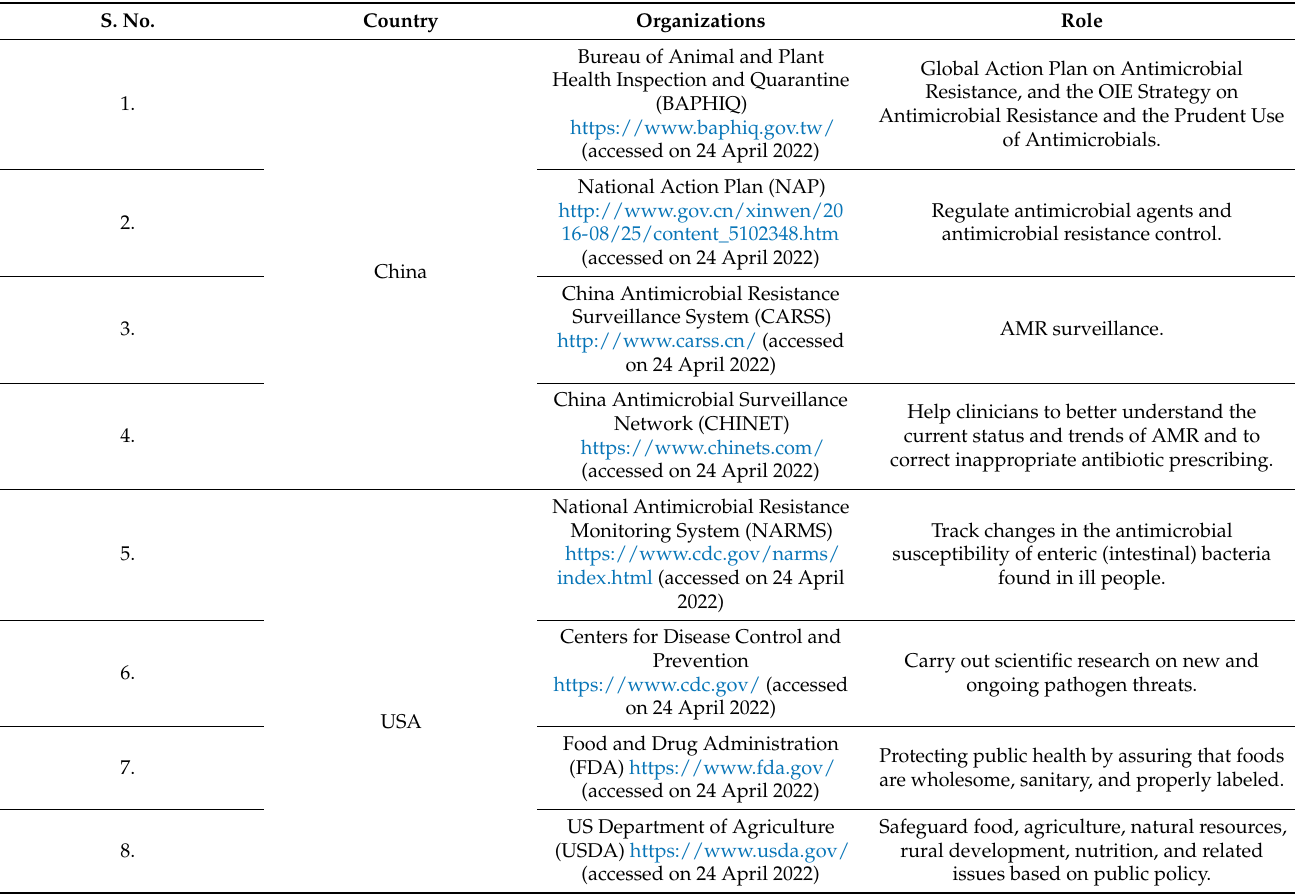
Table 3. Surveillance bodies formed by China and USA to control